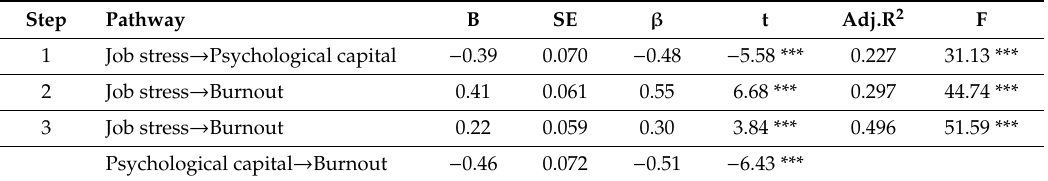
Table 4. Mediating e ff ects of psychological capital on the relationship between job stress and